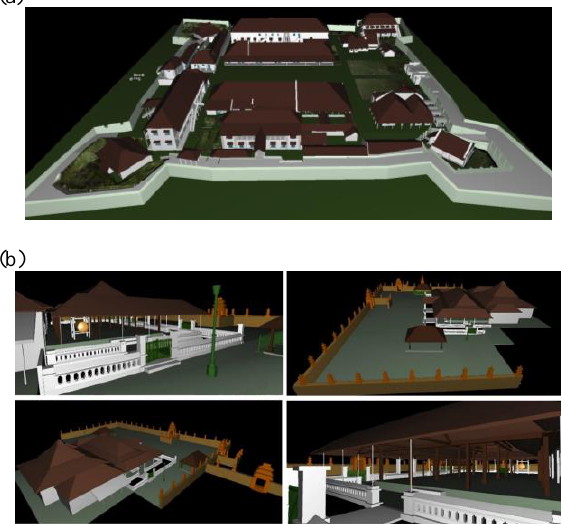
Figure 13. Original image (left). 3D primitive model result Figure 15. Main interface of 3D visualization (right). We also add a spatial function to calculate the distance as well as the area in simple way. For calculating distance between 2 points, users can use I button and define 2 points which want to measure. Figure 16 shows the web 3D version from unity as built into the Web GL platform.